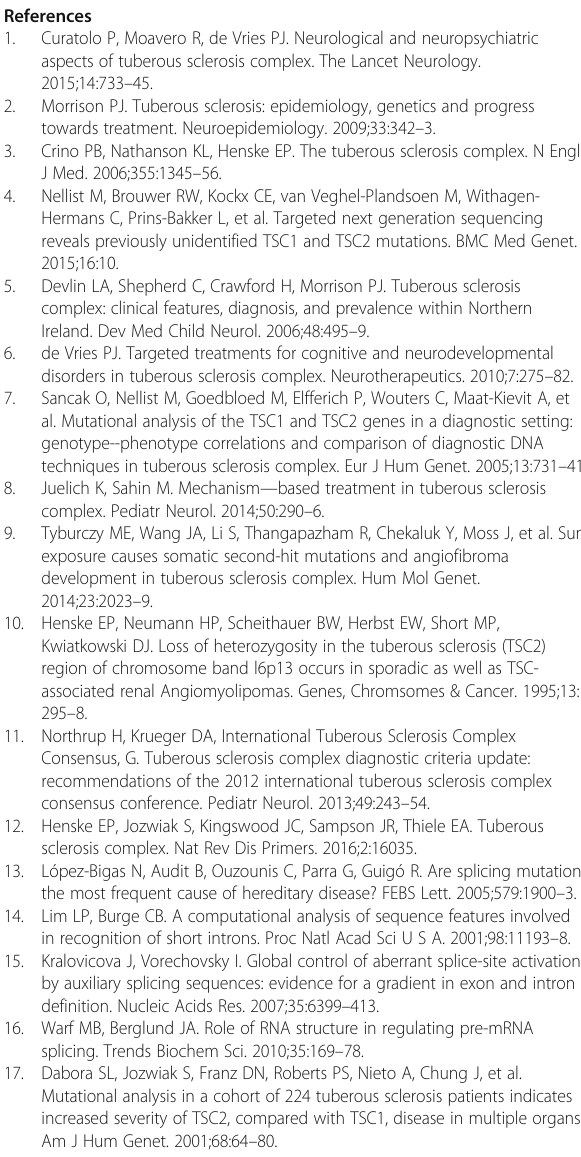
Additional file 2: Figure S1. The mini-gene splicing assay based on the pSPL3 exon trapping vector. A. The pSPL3 vector contains the two exons, namely SD and SA, and a functional intron, with transcription beginning following the SV40 promoter and ending at the LPAS. Wild pSPL3-W and mutant pSPL3-M plasmids containing 293 bp of intron 28, 213 bp of exon 29 and 352 bp of intron 29 were separately cloned into the